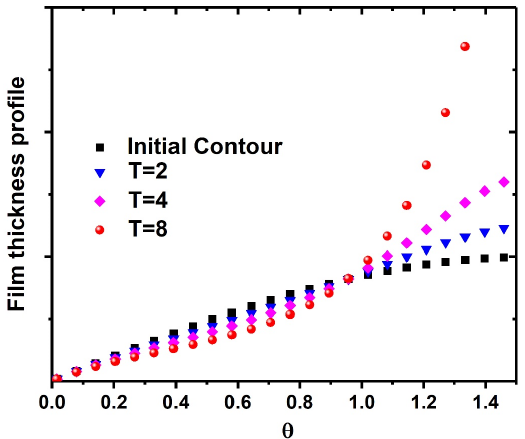
Figure 8. Film thickness profile at different T with non-uniform initial film ( h = h 0sin θ ).